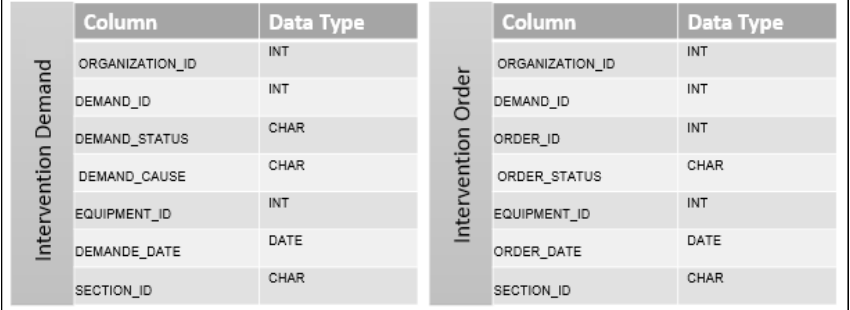
Figure 6. DMP for demand and order of intervention.